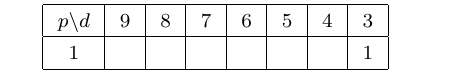
Table 37 . Number of E (8;7) -branes in the p -brane multiplet in d -dimensions. p \ d